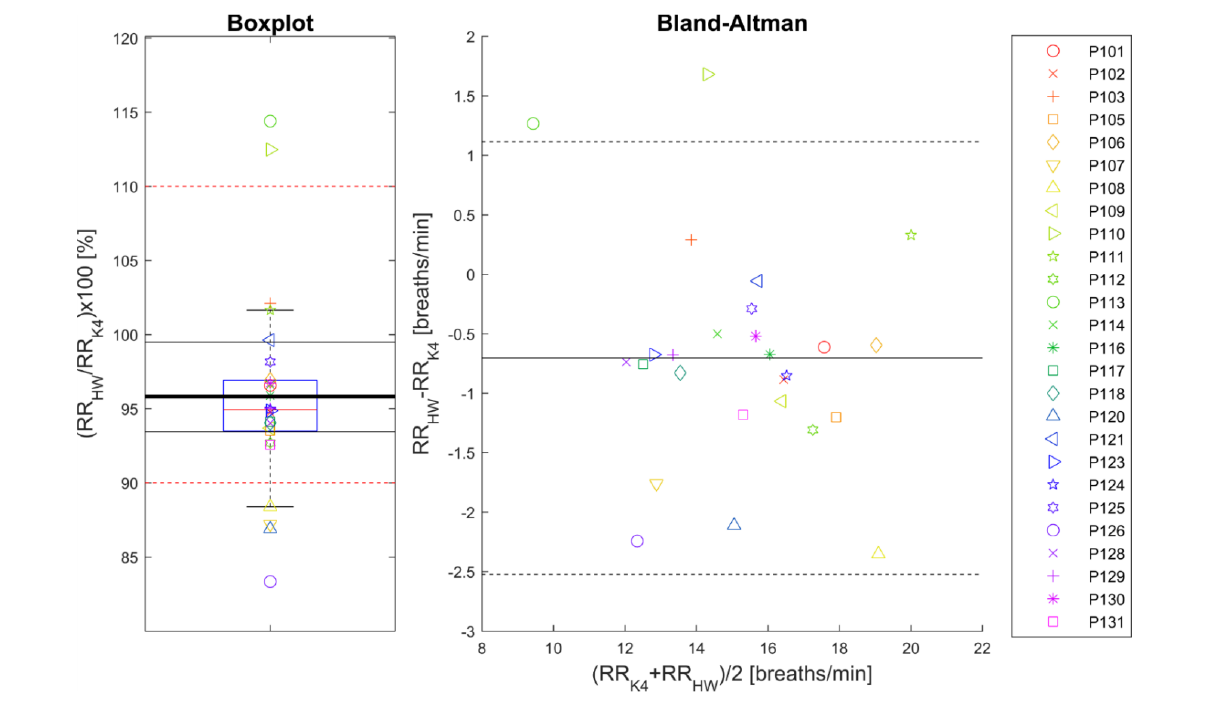
Figure 6. Boxplot (left-hand panel) of the ratio of estimated respiration rate (RR) from the health watch (HW) and the K4b2 (K4) reference, during rest. The thick black line indicates the mean of the data, the red dashed lines the predefined equivalence interval, and the other black lines the calculated 95% CI of equivalence. Right-hand panel: Bland-Altman plot of the estimated RR from the HW and from the reference measurement. The solid black line indicates the average bias and the dashed black lines represent the 95% limits of agreement. Symbols represent participants as indicated in the legend; the legend is the same for both